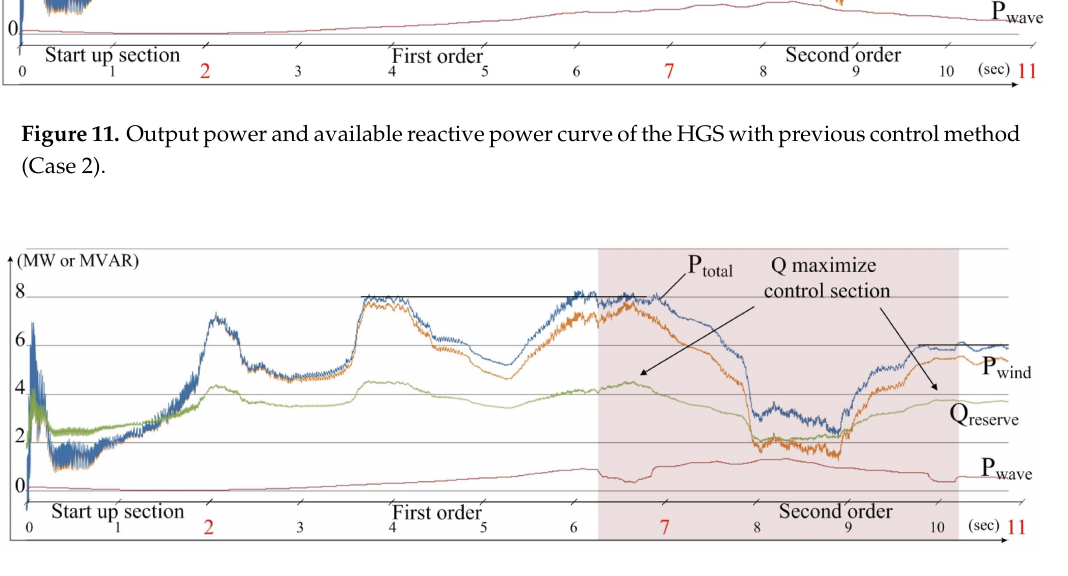
Figure 12. Output power and available reactive power curve of the HGS with proposed control method (Case